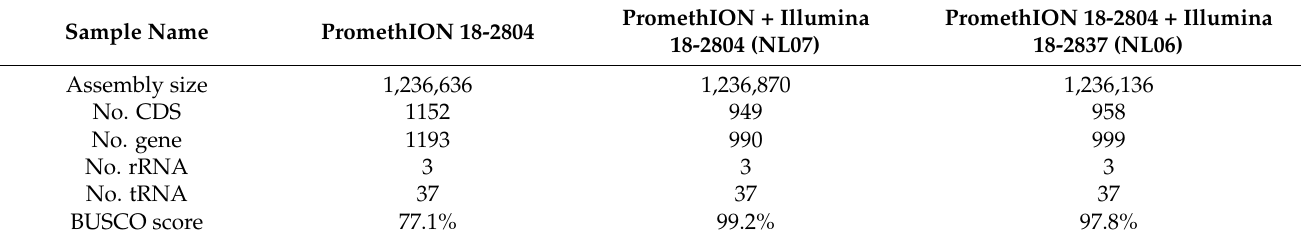
Table 1. Specifications of the unpolished and Illumina polished Ca. N. mikurensis consensus sequences. Note that NL07 was assembled based on PromethION + Illumina data from the same spleen sample (18-2804), while NL06 was assembled based on PromethION data from 18-2804 and Illumina data from 18-2837. All further analyses are based on NL07 only.